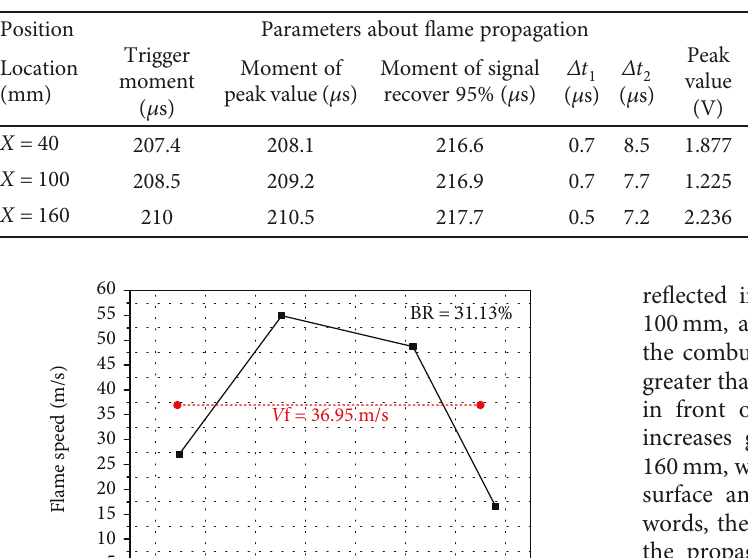
Figure 11: Variation of fl ame structure with time ( BR = 31 13 %). Table 1: Triggering process of wave and fl ame.